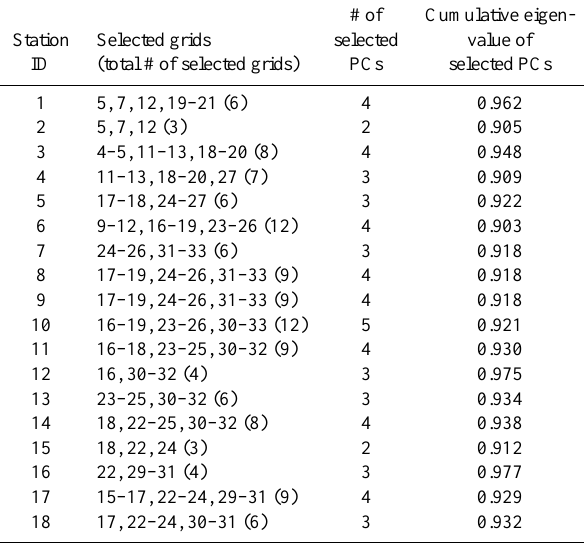
Table 2. Station ID, number of selected PCs, and cumulative eigen- values for large-scale precipitation grids from the NOAA’s GFS model, which provides 1-day ahead precipitation forecasts (grid numbers are shown in Fig.